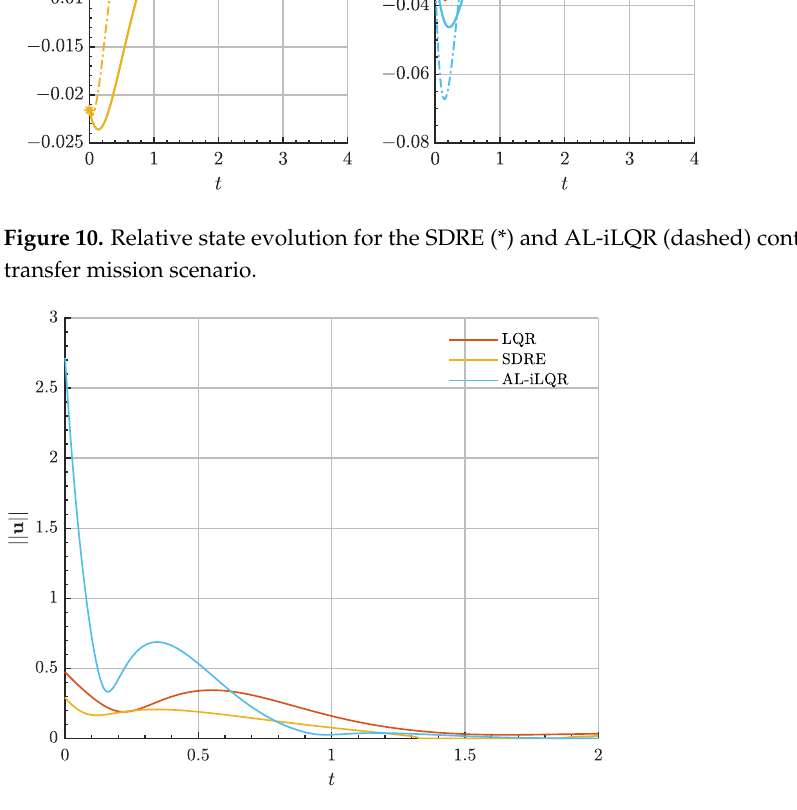
Figure 11. Control acceleration in mm/s 2 for the LQR, SDRE and AL-iLQR controllers for the halo transfer mission